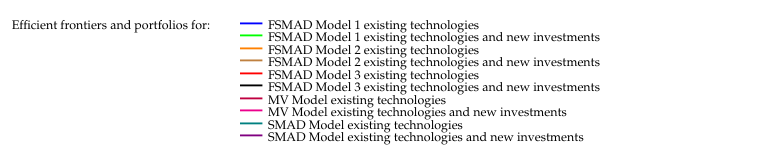
Figure 3. Comparison of the efficient frontiers obtained with all models